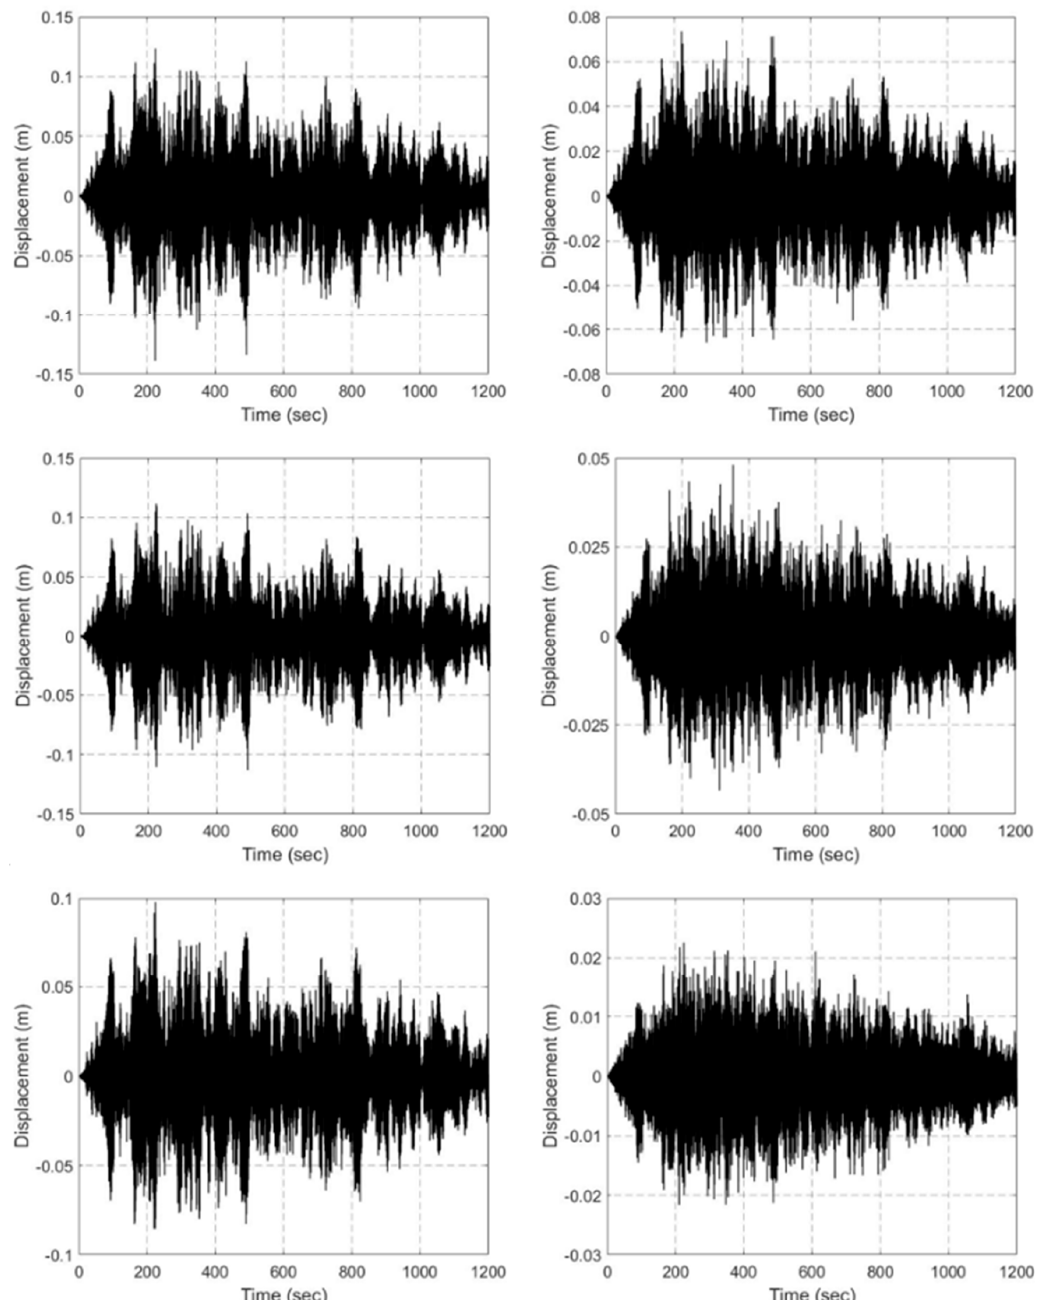
Figure 6. Nonstationary response signal of six-DOF chain model of a cantilever beam. Table 1. Modal parameter identification result of six-DOF chain model of a cantilever beam.